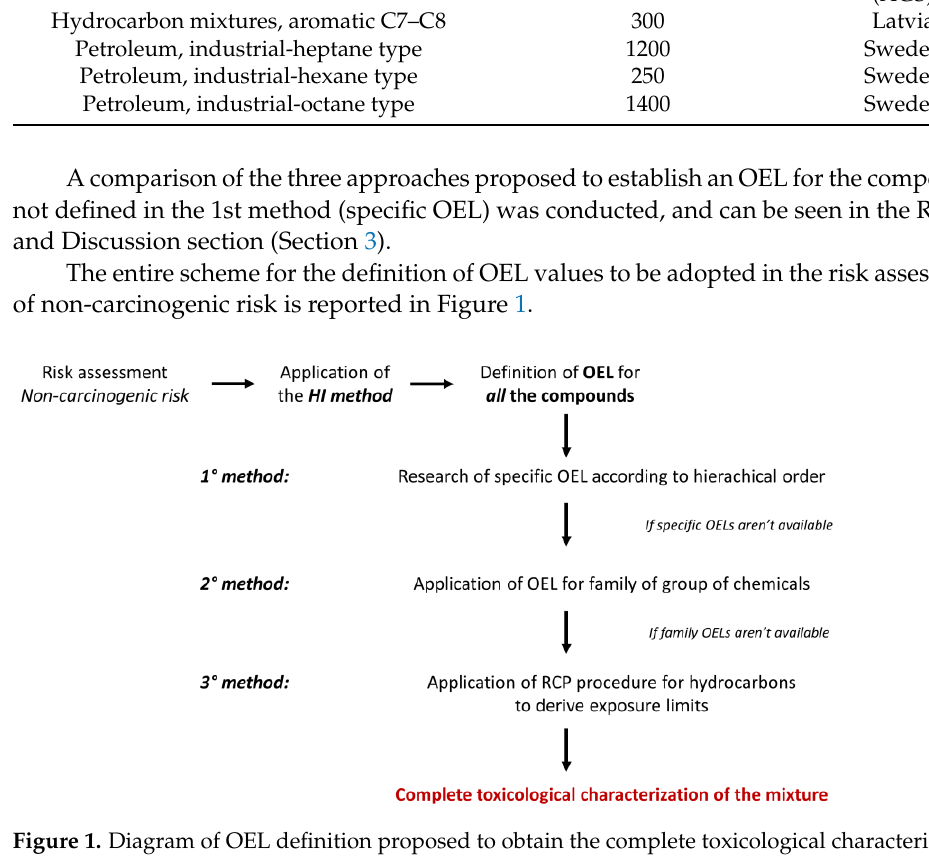
Table 1. ELs adopted in the 2nd method for family/group of chemicals.